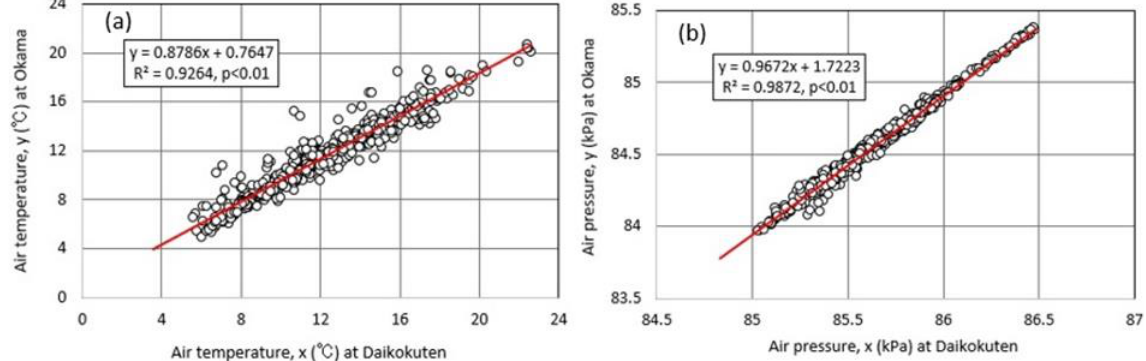
Figure 13. Relationship between ( a ) air temperature and ( b ) air pressure between Daikokuten and the Okama (site M) by using the hourly data of 1 – 28 September 2021.